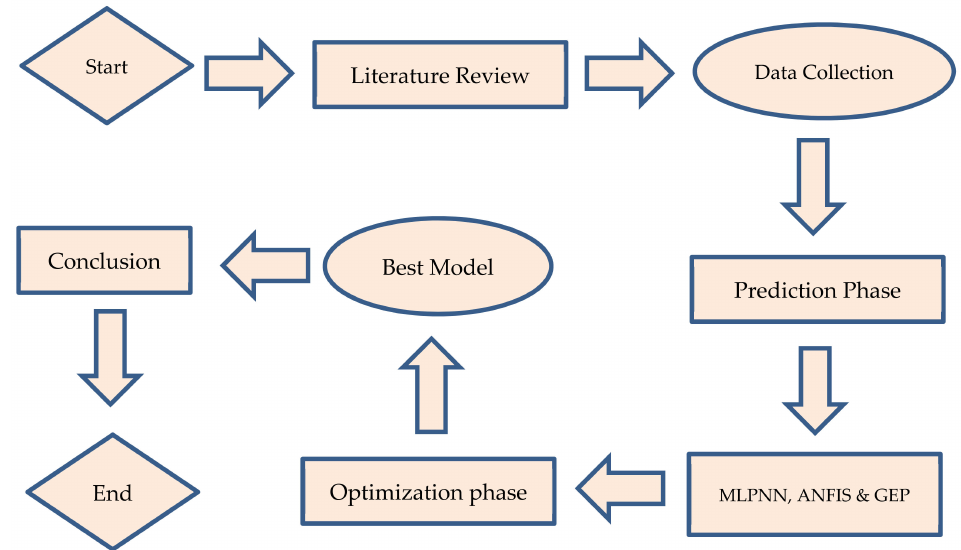
Figure 2. Machine learning